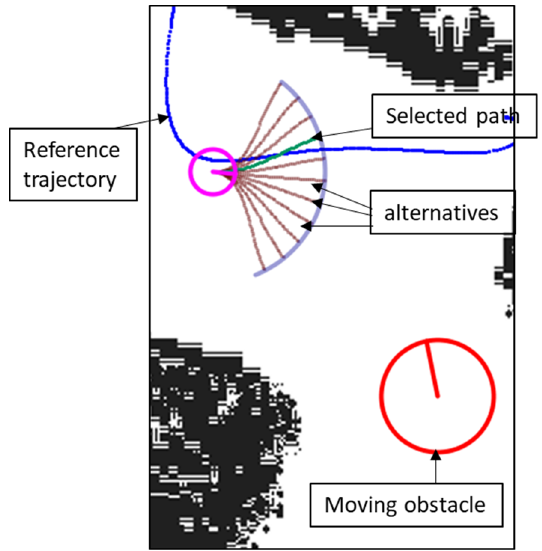
Figure 13. Visualization of sub-trajectories constructed by alternatives of the weighted-sum model.